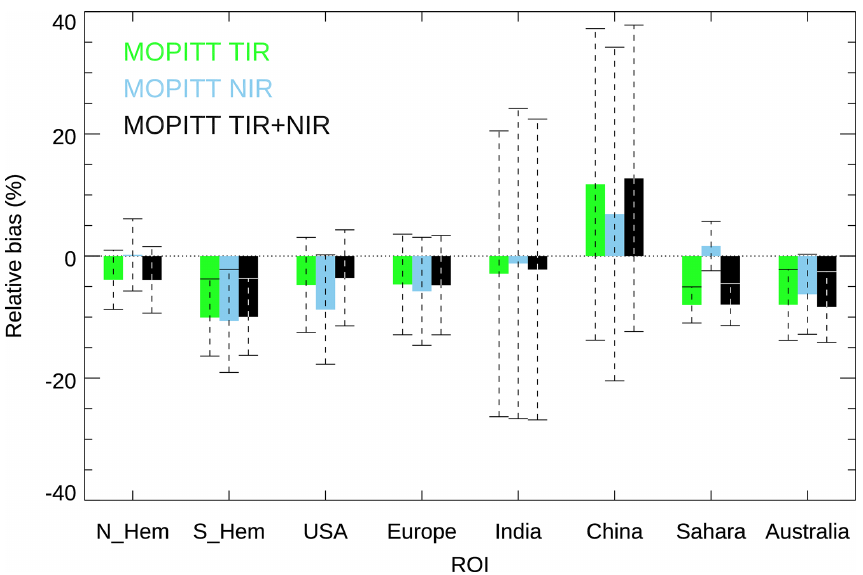
Figure 13. Summary of non-colocated land comparison results. Colored bars represent relative bias between TROPOMI and each of the three MOPITT products (TIR, NIR, and TIR + NIR). Dashed lines show ± 1 SD of mean daily relative biases (i.e., inter-daily bias variability).